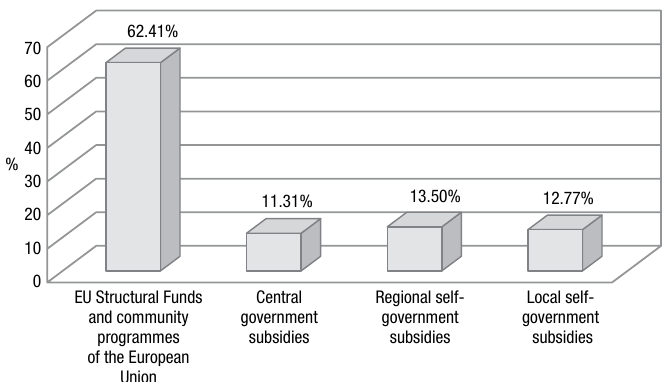
Fig. 4. Percentage of public funds in the cluster budgets in the countries of the modest